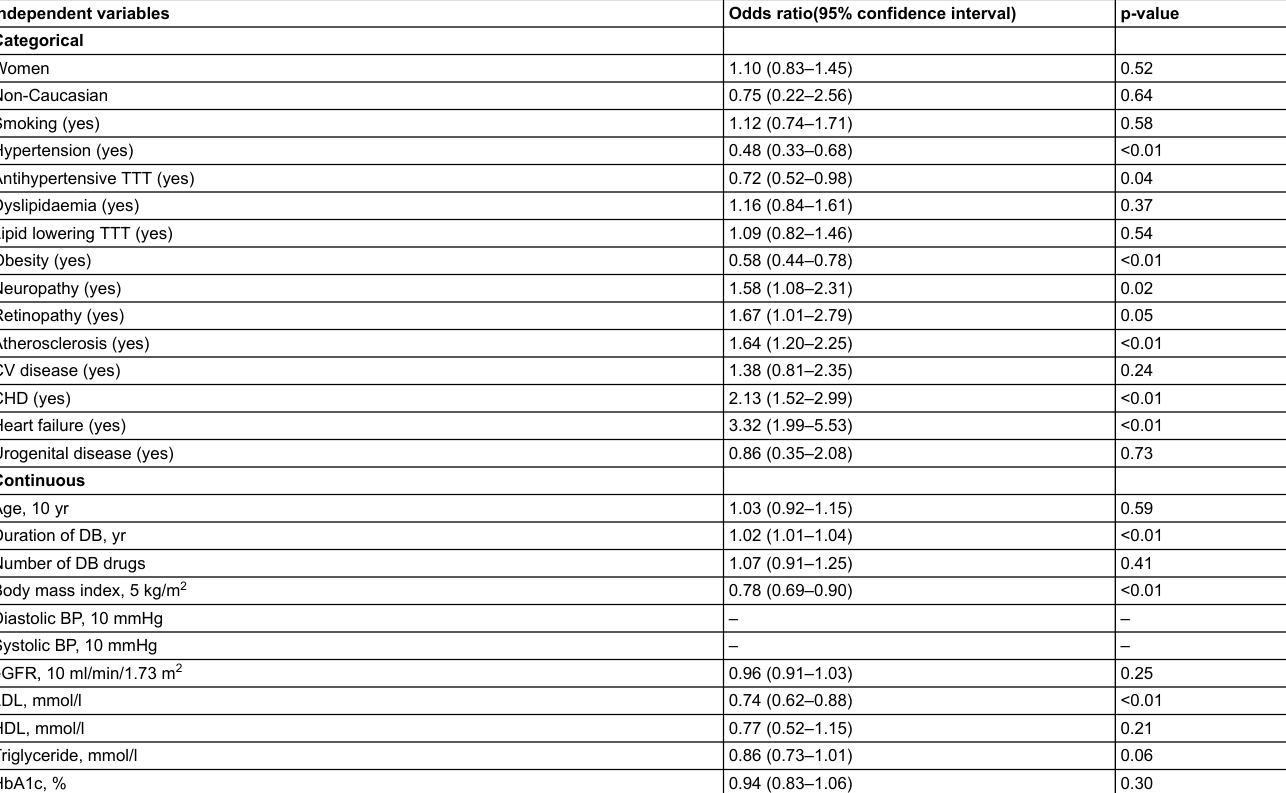
Table 4: Odd ratios for blood pressure goal attainment in univariate analysis (n = 1354). Independent